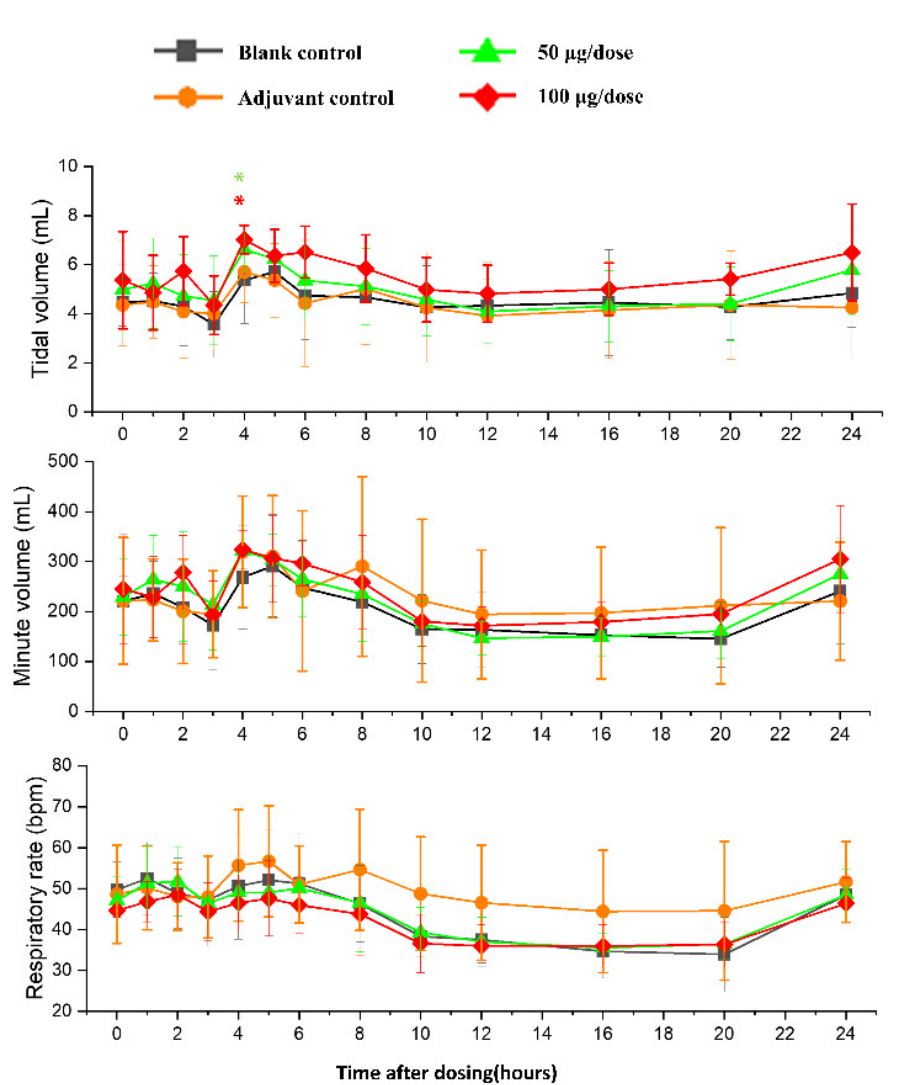
Figure 8. The effects of intramuscular injection of ZF2001 on tidal volume, minute volume and respiration rate in cynomolgus monkeys, * p < 0.05 at 3–4 h, n = 8 in each group. vs. the blank group.